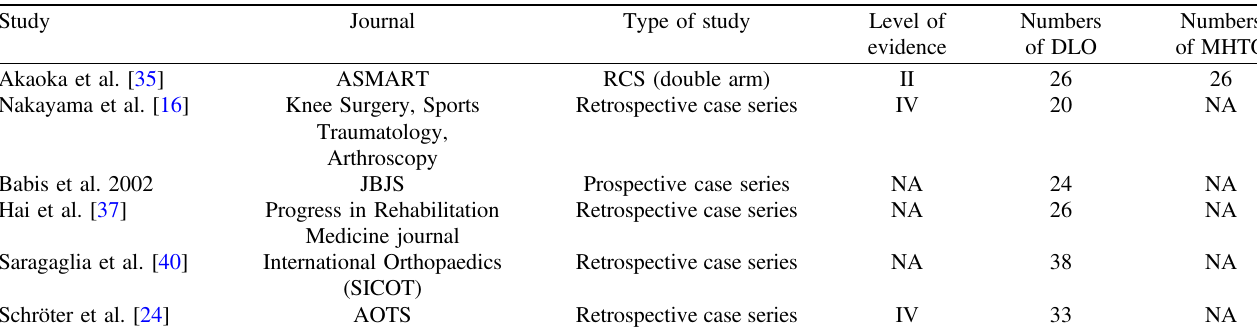
Table 1. Study ’ s